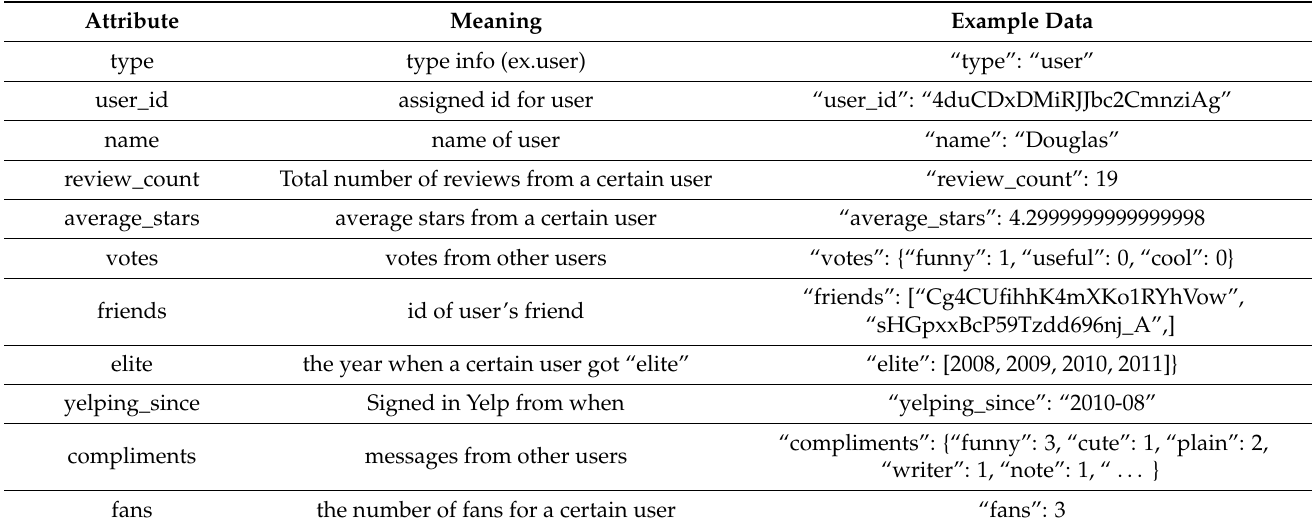
Table 1. User object in the Yelp